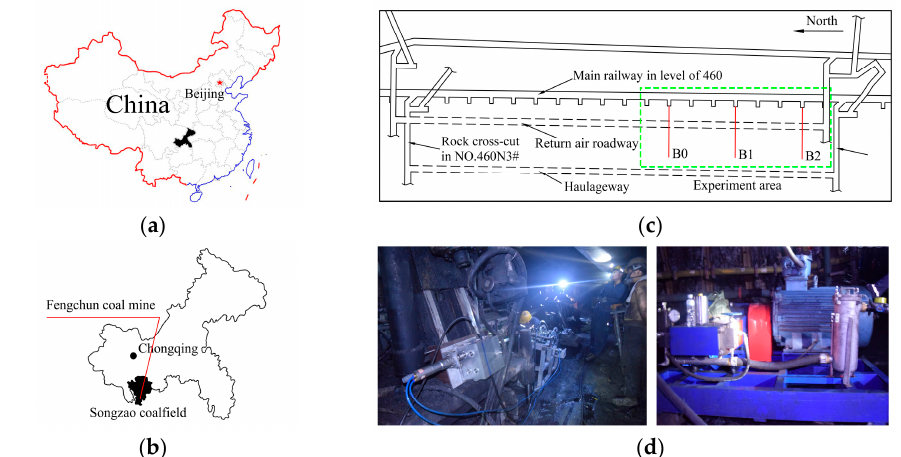
Figure 6. Maps showing the location of the field test study site and photographs of the drilling equipment. ( a ) Location of Chongqing province in China; ( b ) Location of the Songzao coalfield and the Fengchun mine, Chongqing province; ( c ) Plan showing the roadway layout of mining area No. 8 and the location of the roadway for gas drainage below the mechanical roadway in the Fengchun mine; ( d ) The equipment used for tree-type